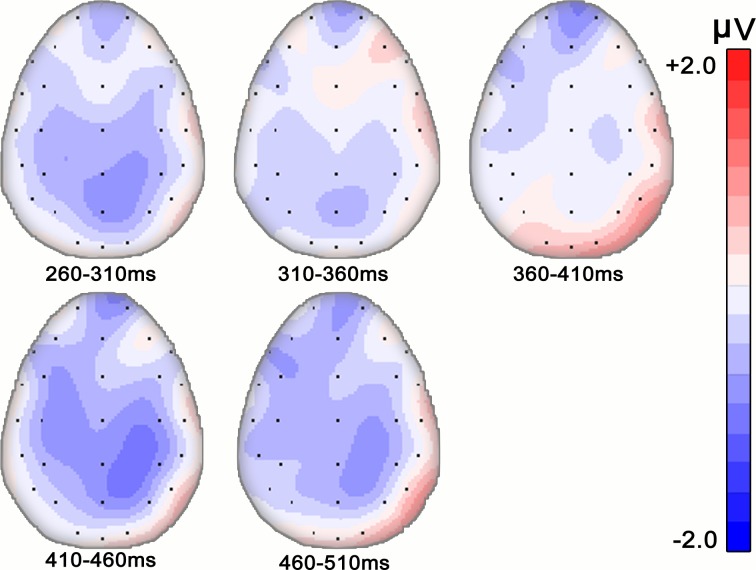
Time course of N400 effects in Experiment 2 (non-music major group).Difference-wave topography is shown in maps of 50ms duration from 260ms to 510ms.